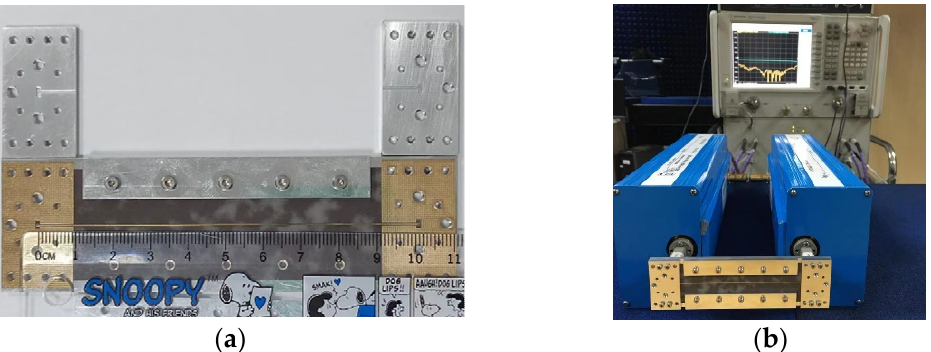
Figure 9. The designed back-to-back transition. ( a ) Photograph of the fabricated prototype. ( b ) Test scenario.